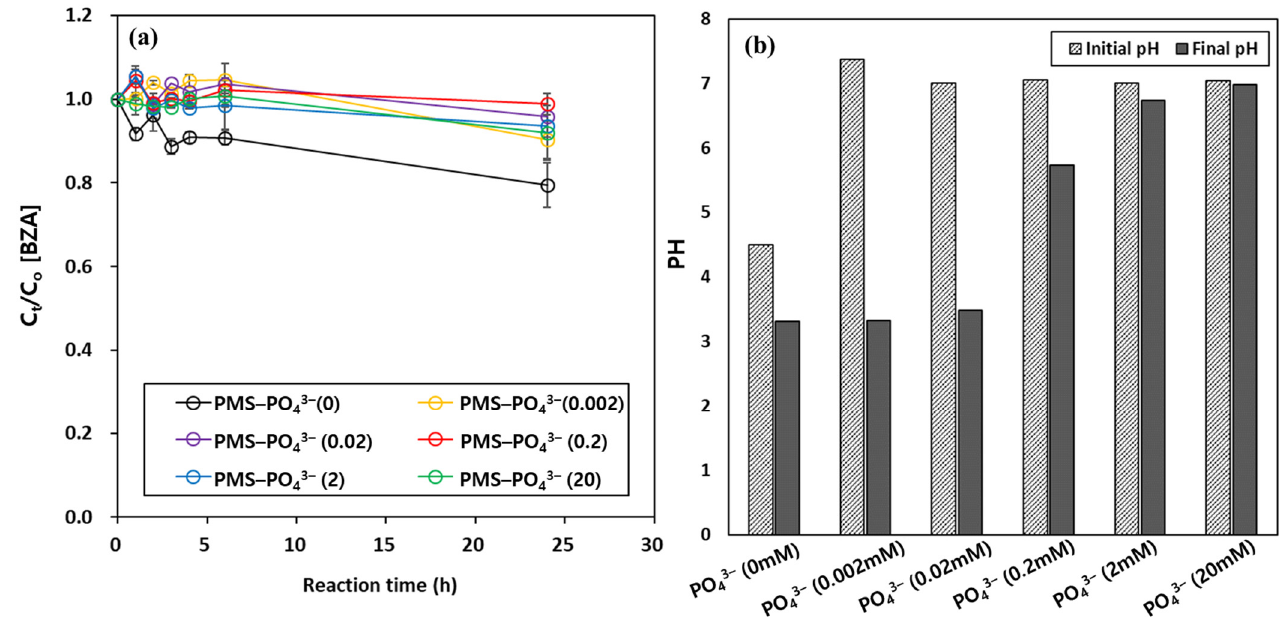
Figure 7. ( a ) Effect of phosphate ion concentrations on benzoic acid (BZA) decomposition by PMS oxidant, ( b ) the change of pH over the reaction ([BZA] = 20 µM, [PMS] = 200 µM, [phosphate ions] = 0~20 mM).